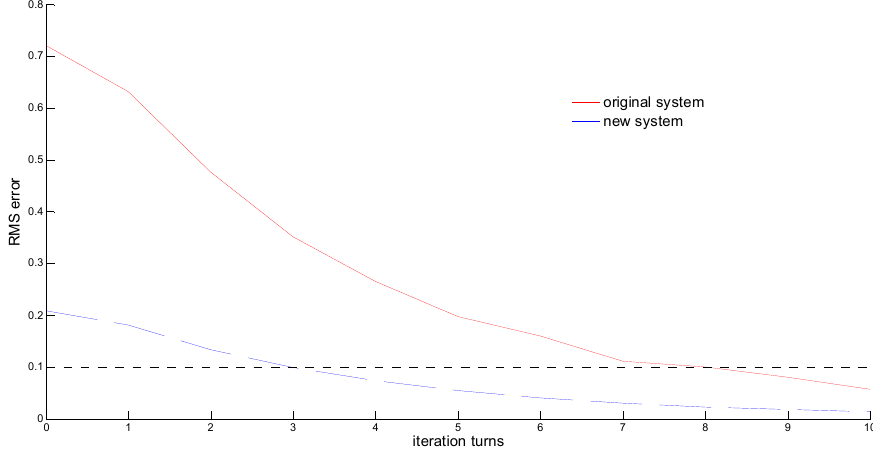
Figure 10. PD-ILC/Sine Curve of Translational Experience Figure 10. PD - ILC/Sine Curve of Translational Experience Transform. Figure 10. PD - ILC/Sine Curve of Translational Experience Transform.